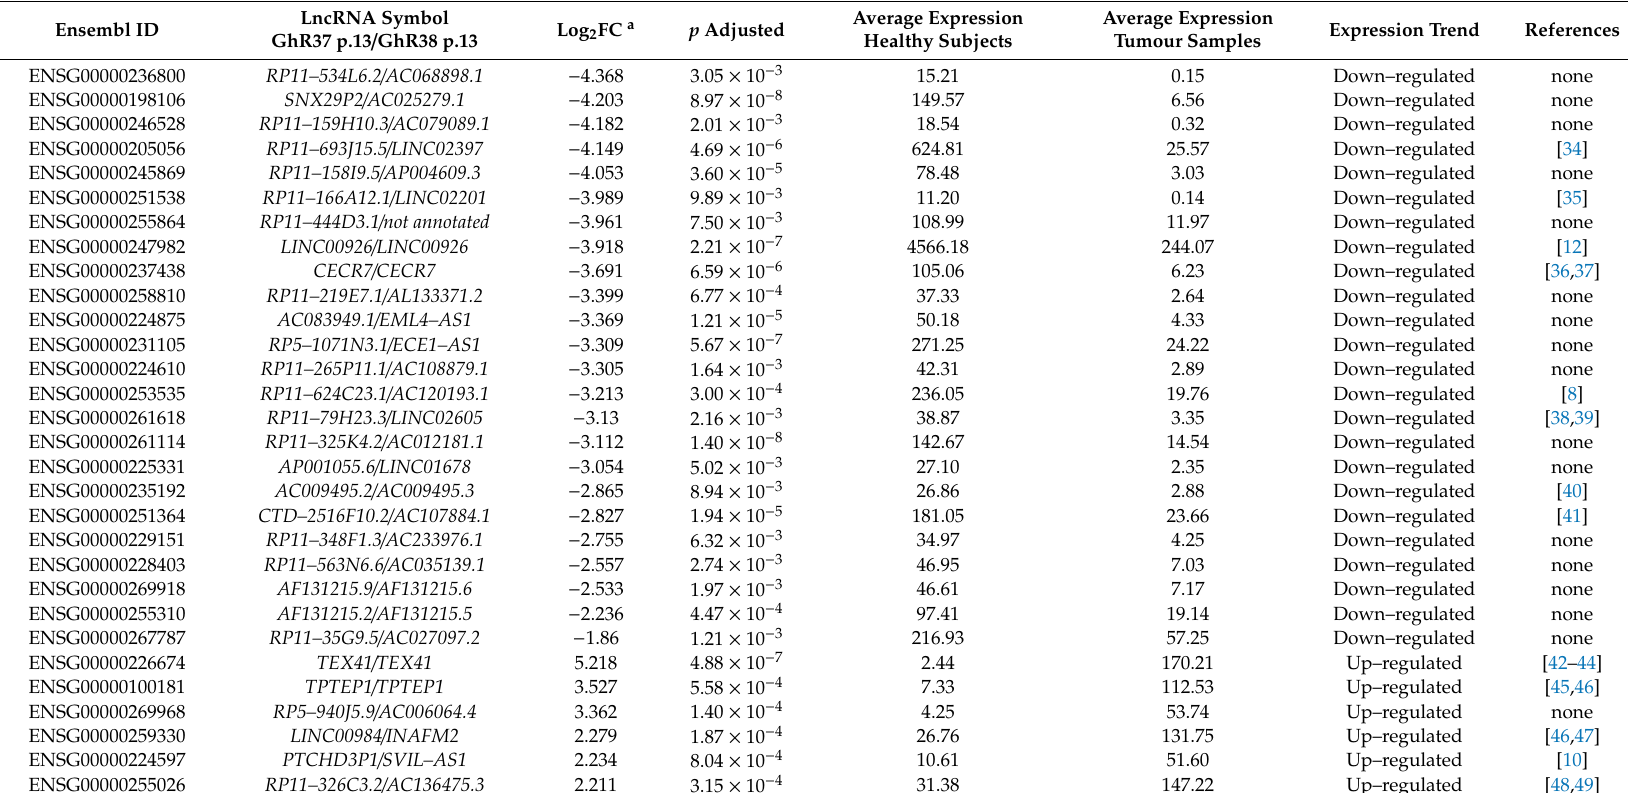
Table 1. Annotations and expression profiling of the 30 lncRNA signatures as diagnostic candidates in paediatric